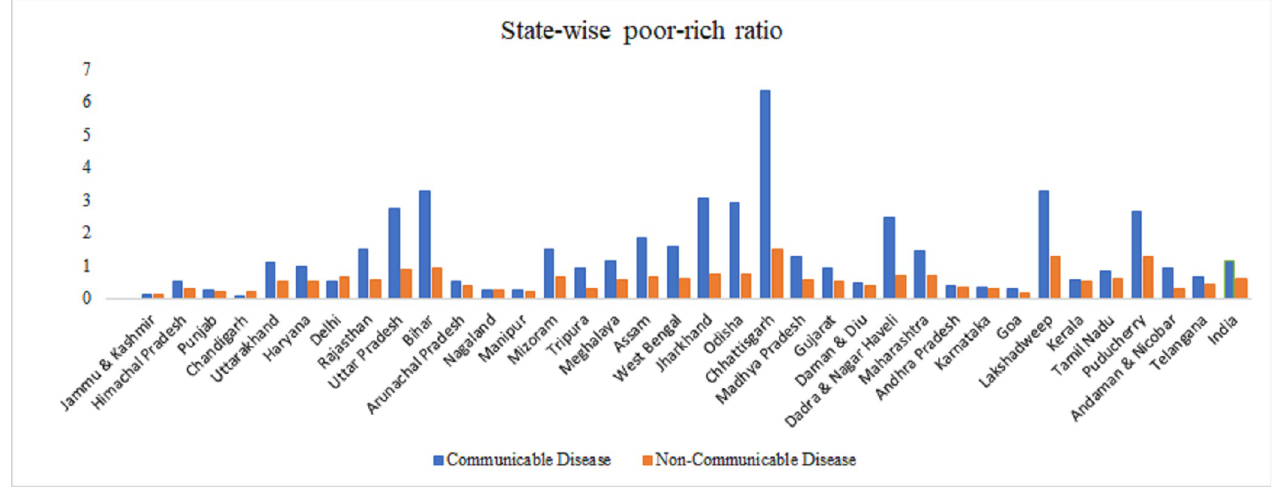
Fig 4. State-wise poor-non-poor ratio in prevalence of communicable and non-communicable diseases.